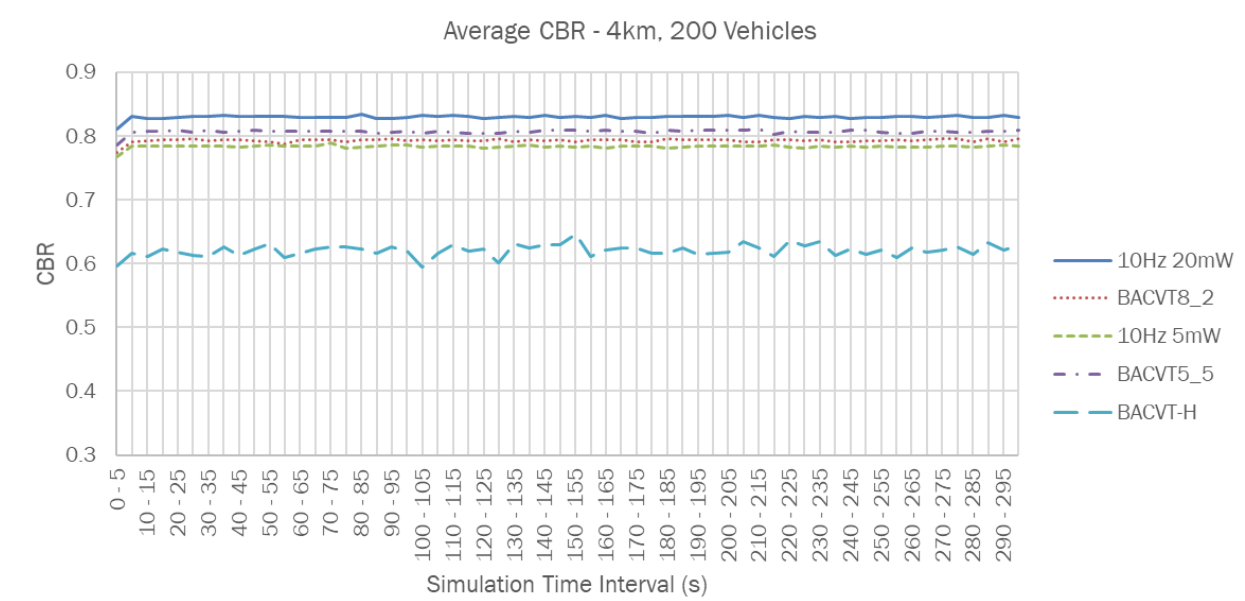
Figure 4. Average CBR in high vehicle density.